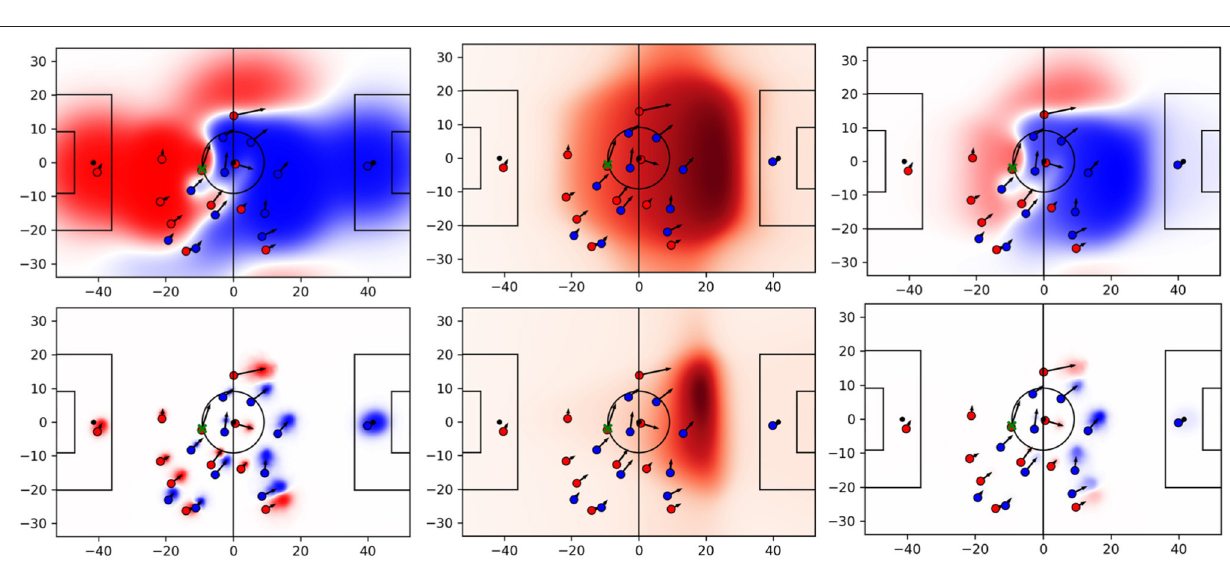
FIGURE 8 | PC (left column) , pitch value (center column) , and space quality (right column) for baseline (top row) and proposed approach (bottom row)